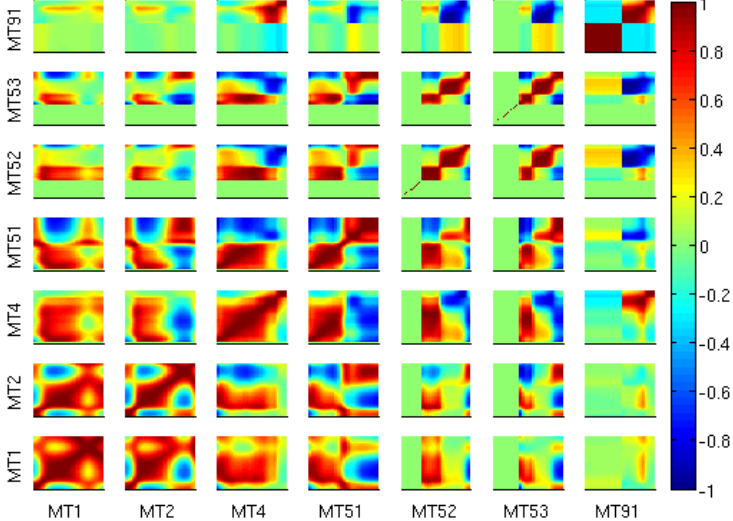
Figure 2. Correlation matrices between different angle-integrated cross sections denoted by the corresponding MT